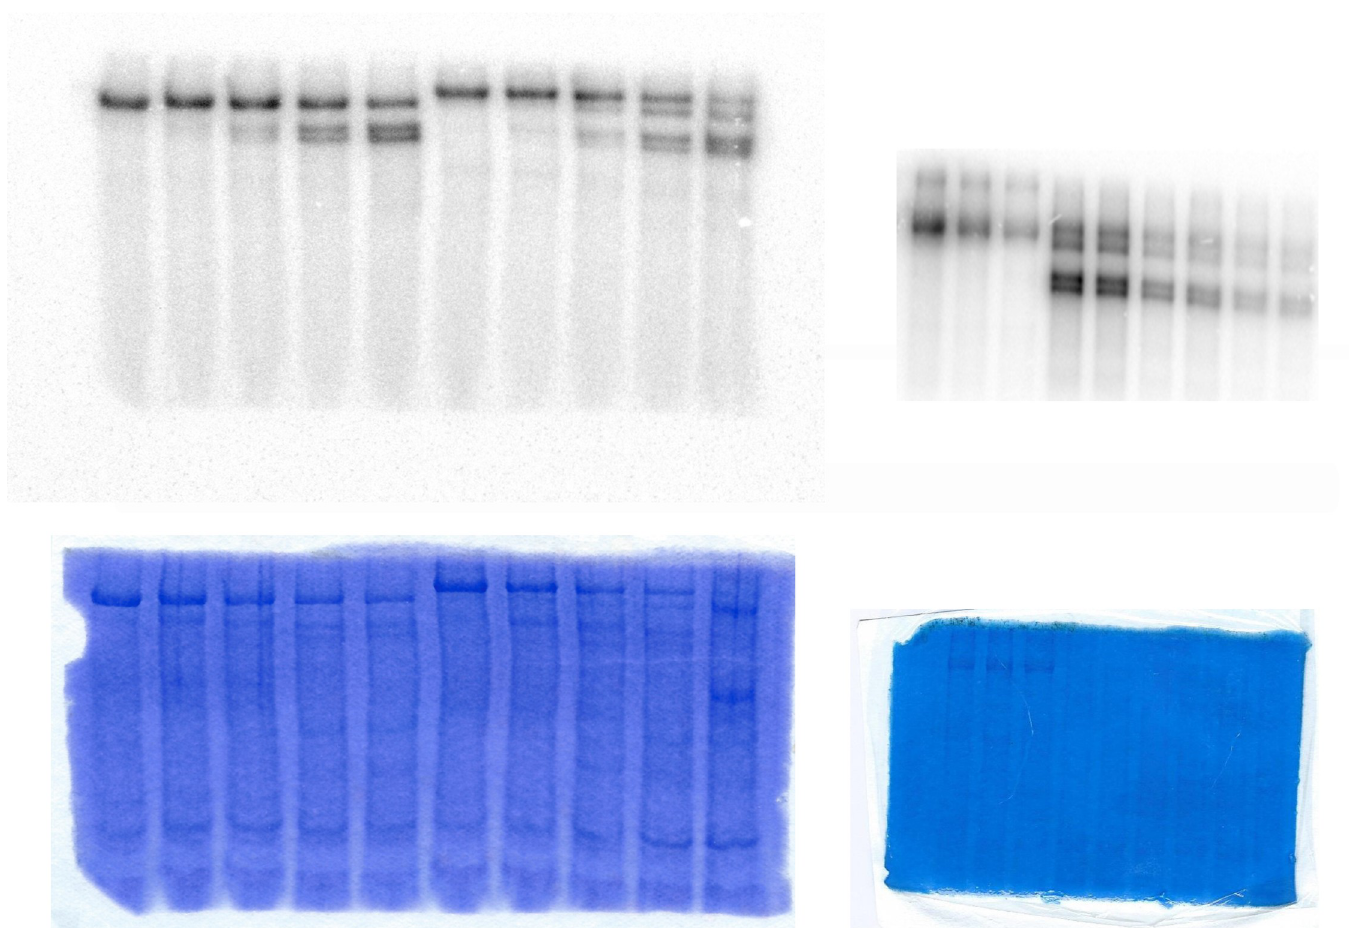
Fig 7. Formation and decomposition of the catalytic phosphoenzyme by the chymotrypsin treated Spf1p and Spf1p-GFP. The Spf1p and Spf1p-GFP proteins were digested with chymotrypsin at a (w/w) ratio of 30:1 protein to chymotrypsin. After the time indicated on top of each lane the proteolysis was stopped by adding 2.5 μ g of aprotinin and cooling to 4˚C. The phosphorylation reaction (left panel) was started by the addition of 0 . 5 μM [ γ 32 P]-ATP and terminated after 30 s by the addition of TCA. For dephosphorylation ( Dephos , right panel) digested samples were phosphorylated for 60 s with 0 . 5 μM [ γ 32 P]-ATP and the dephosphorylation reaction started by the addition of 0.5 mM ATP. After the times indicated on top the reaction was stopped by the addition of TCA. The samples were electrophoresed in an acidic 7.5% SDS-PAGE and revealed by Colloidal Coomassie staining ( bottom panels) and radioactivity ( top panels ). The migration of the Spf1p-GFP proteolytic product probably generated by the cleavage at the C-terminus of Spf1p is indicated with a star symbol ( ☆